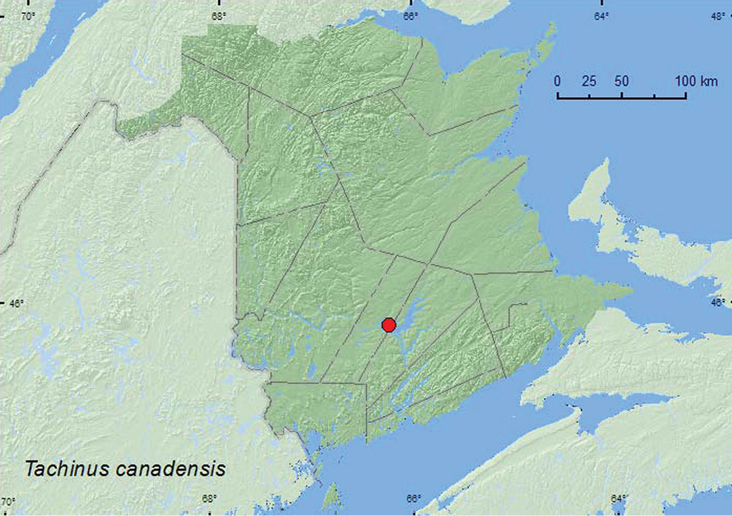
Collection localities in New Brunswick, Canada of Tachinus canadensis.